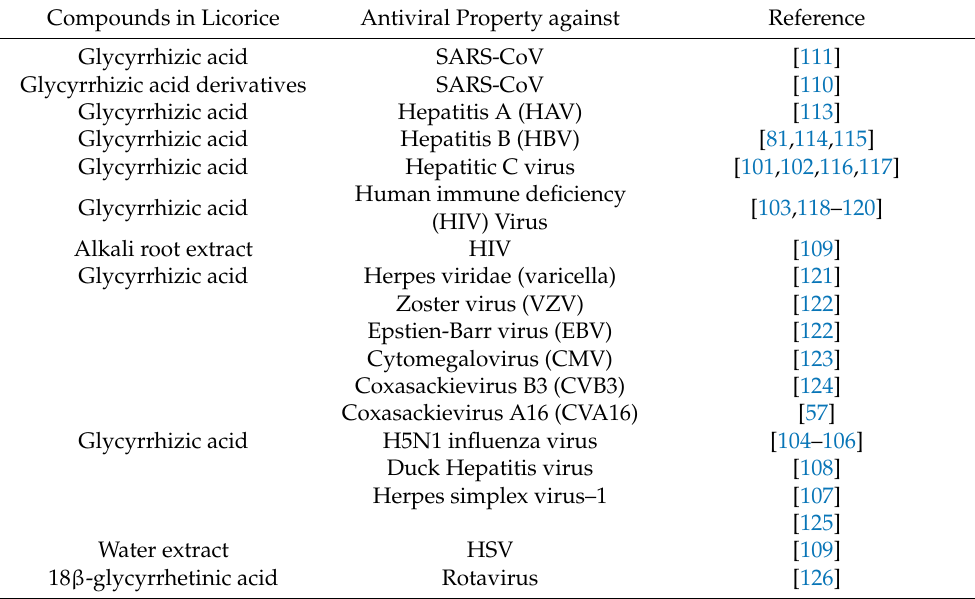
Table 2. A list of significant phytochemicals present in licorice and their antiviral efficacy. Compounds in Licorice Antiviral Property against Reference Glycyrrhizic acid SARS-CoV [111] Glycyrrhizic acid derivatives